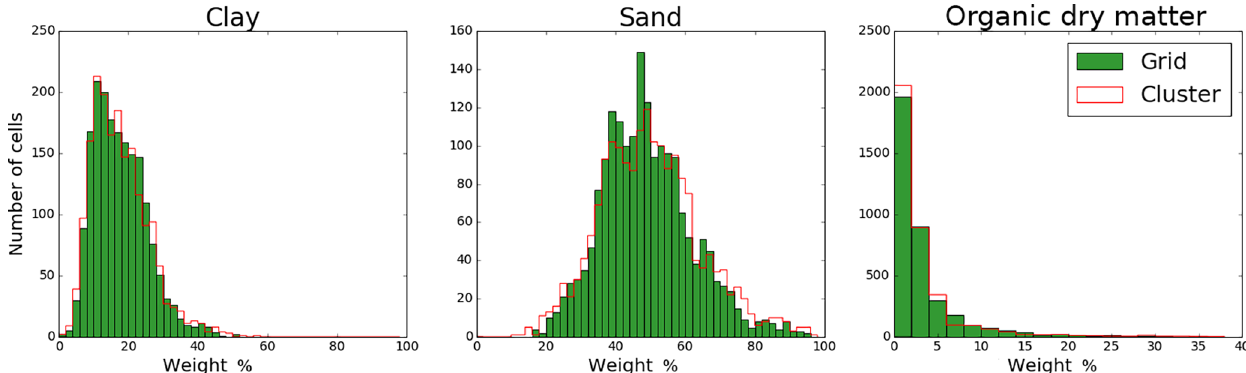
Figure A5. Histogram of the mean clay, sand, and organic matter content for CLASS-CTEM grid cells based on the simple mean value of all GSDE cells (green) or the weighted mean of the clusters within a CLASS-CTEM grid cell (red